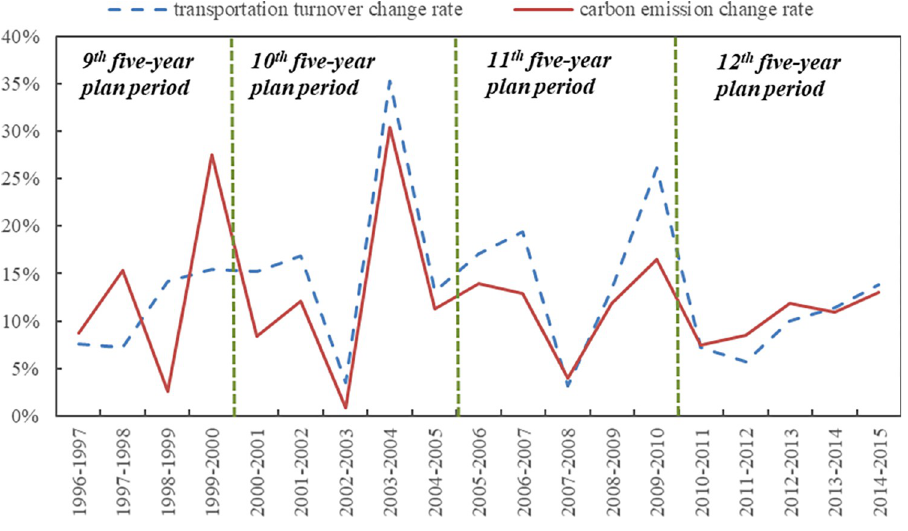
Fig 2. Change rates of civil aviation transportation scale and CO 2 emissions,